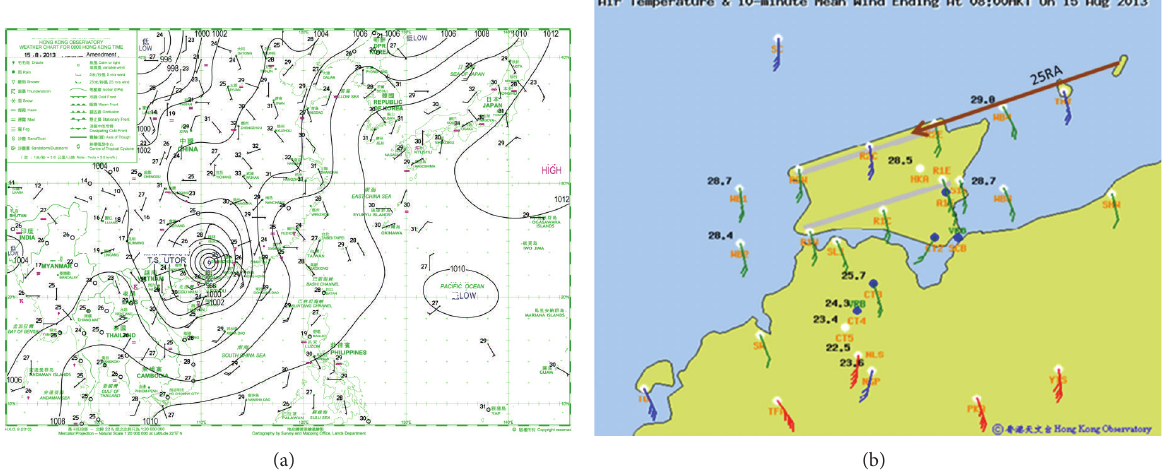
Figure 3: Weather overview at 8am on 15 August 2013. (a) is a surface isobaric chart showing that tropical storm Utor is located at around 23.0 N, 110.8 E. (b) is an overview of wind speeds and directions as measured by the ground-based anemometers and weather buoys in the regions of Hong Kong International Airport and Lantau Island.